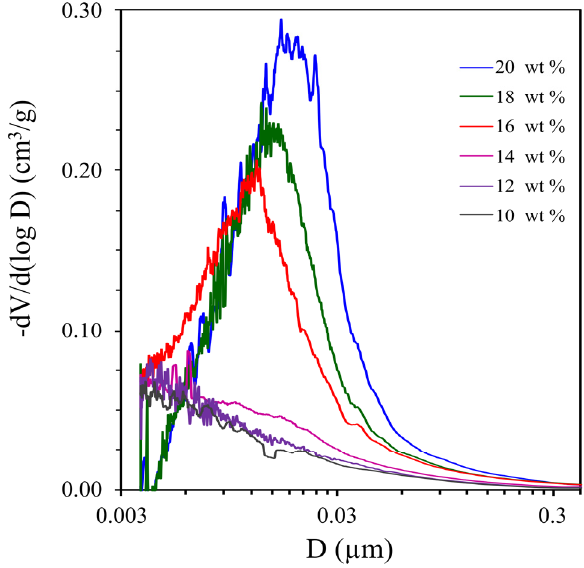
Figure 3. The pore size distribution of poly-OCM-2 monoliths (M2-M7) obtained from OCM-2 in the presence of 1-butanol (10–20 wt %).